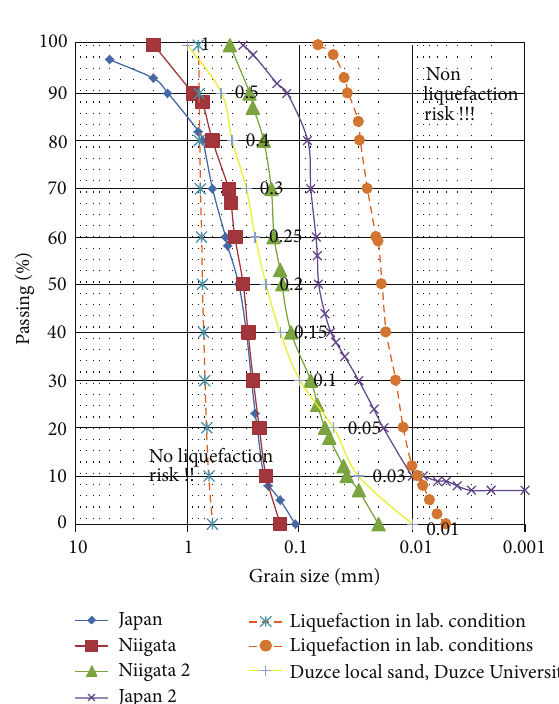
Figure 1: Grain size distribution of sandy